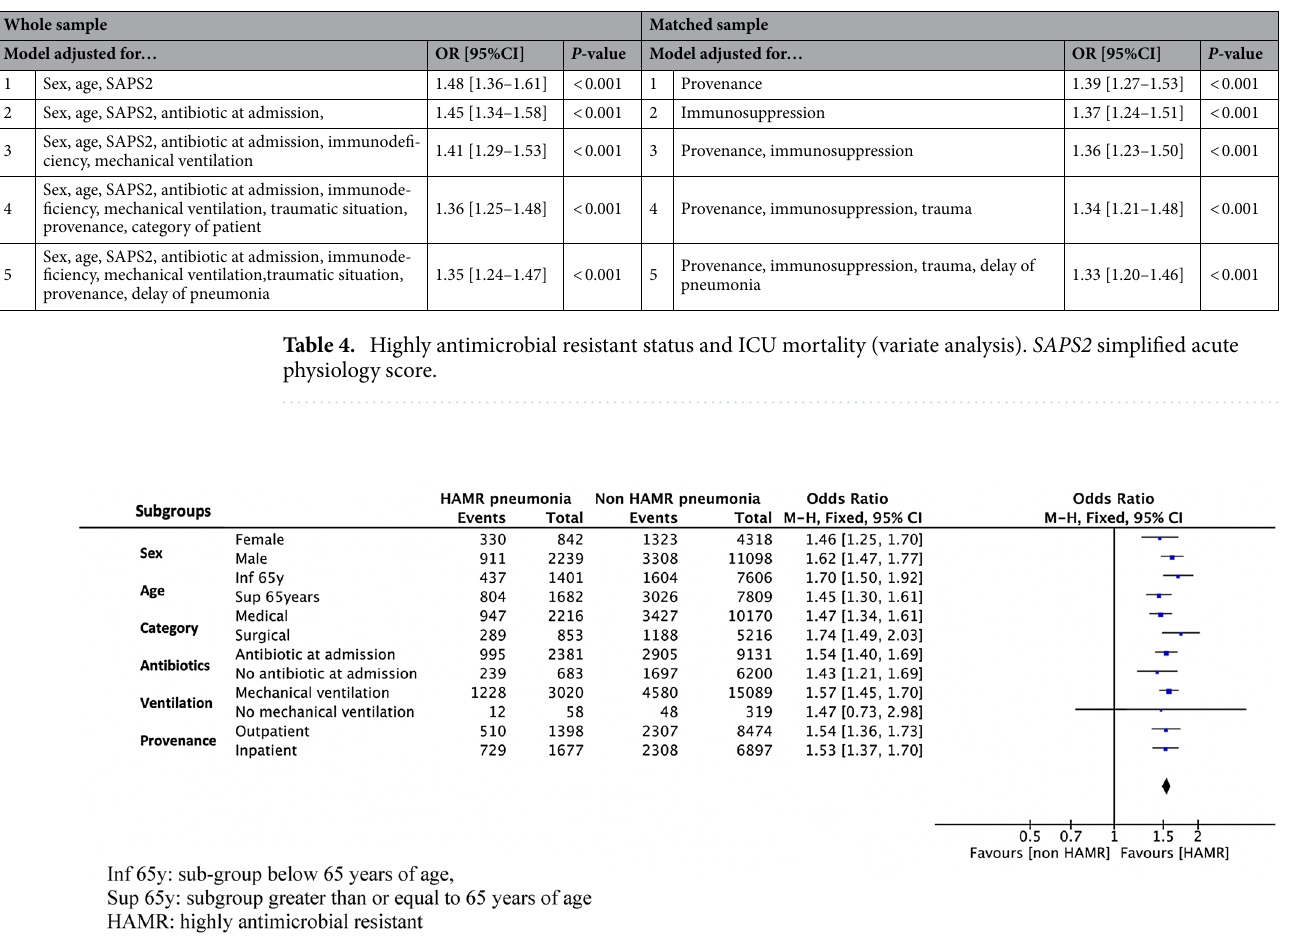
Figure 2. Risk of mortality associated with HAMR status by